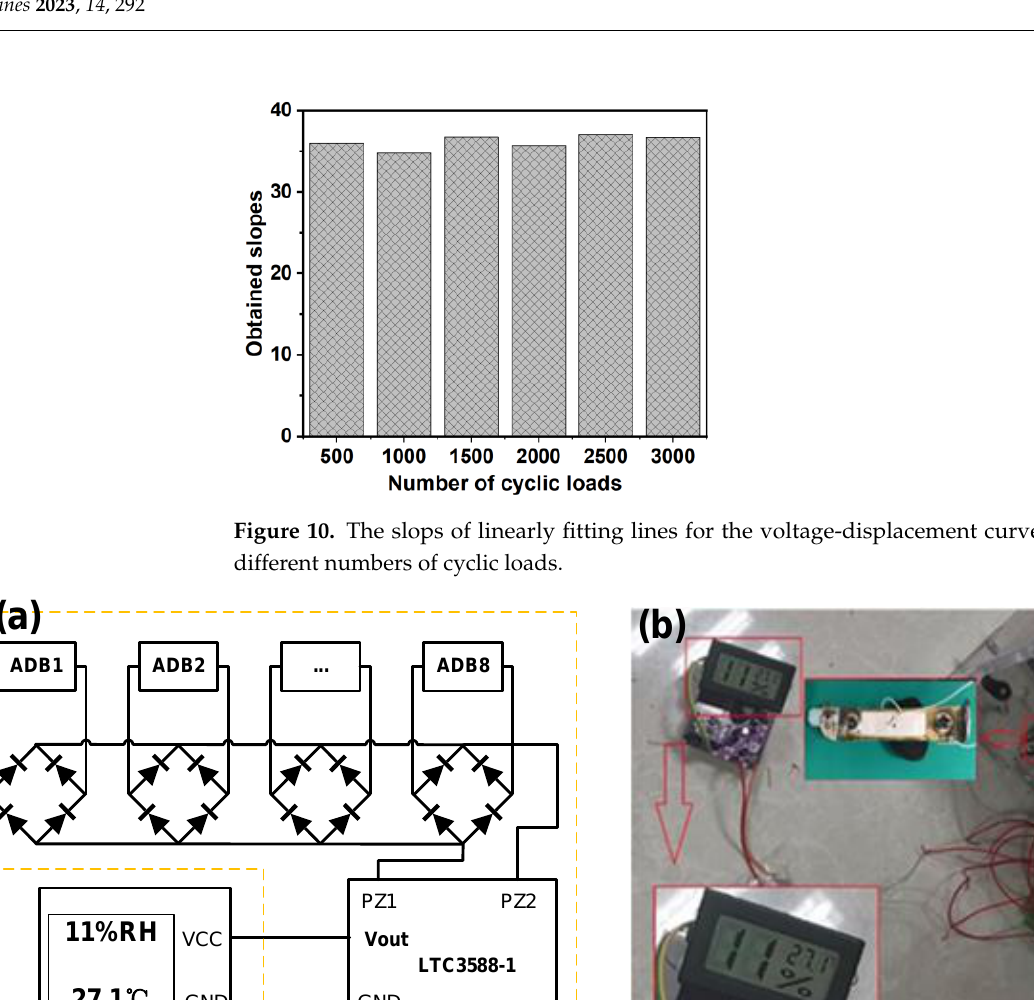
Figure 11. Applying proposed PPEH in powering a low-power sensing device. ( a ) Circuit diagram of the system; ( b ) Picture of the powered sensing device.